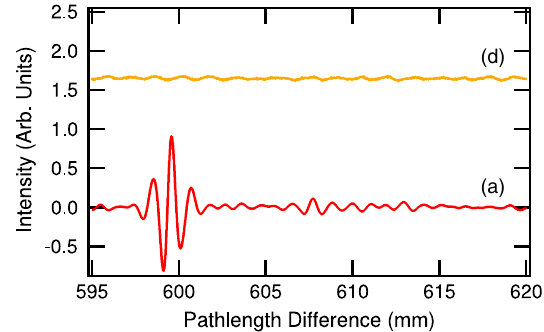
FIG. 2. Expanded view of Figs. 1(a) and 1(d) near a PLD of 600 mm representing the interference between adjacent bunches. Note that no evidence of interference between bunches is seen in